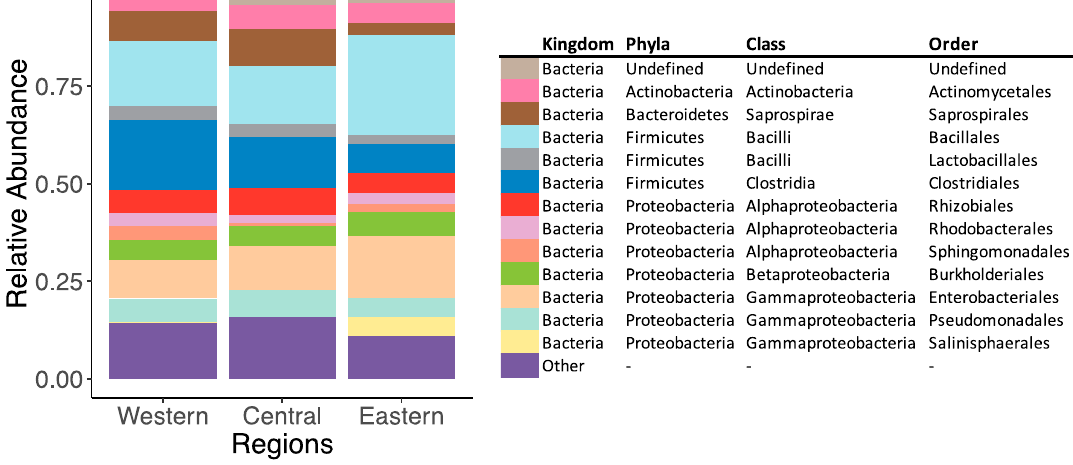
Figure 4. Relative abundance of prokaryote operational taxonomic units (OTUs) in the different regions of the MS. The colors correspond to different taxonomic orders of prokaryotes, as shown in the detailed legend.